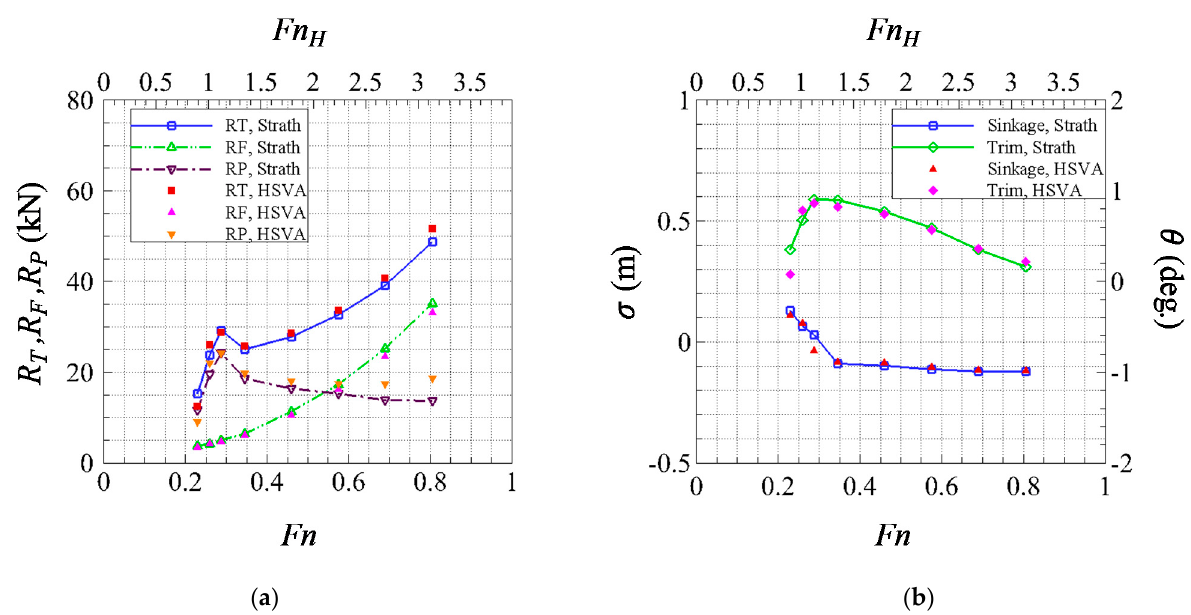
Figure 8. Resistances ( a ) and motions ( b ) of the London Demonstrator in shallow water ( H = 2.15 m).